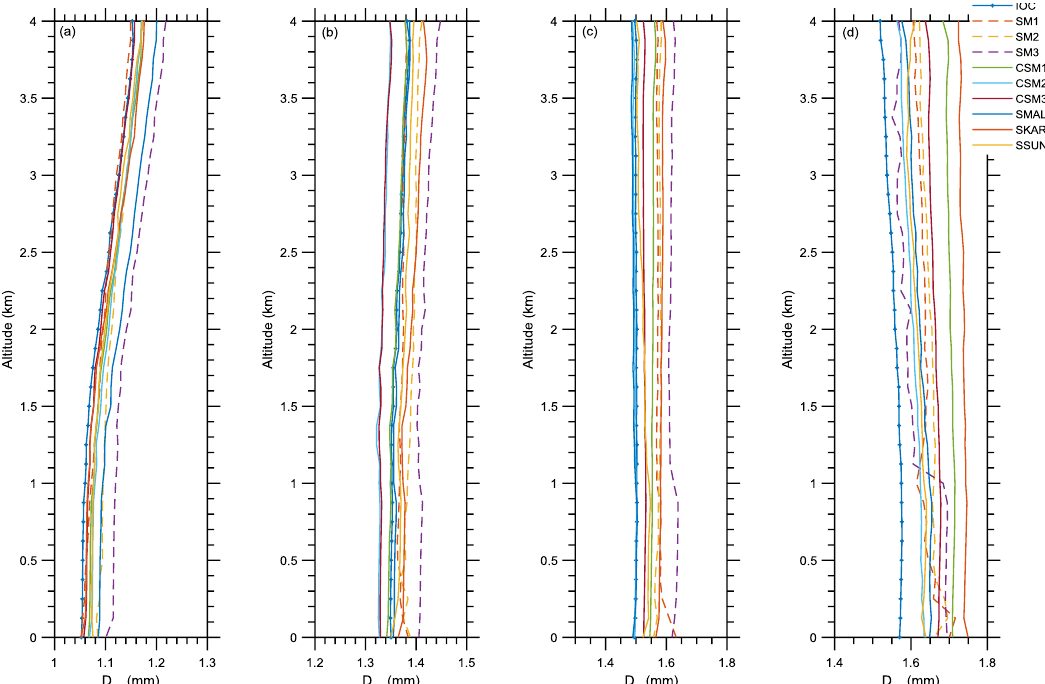
Figure 5. Vertical profile of mass-weight mean diameter ( D m ) for ten selected locations of stratiform rain for a) very light rain, b) light rain, c) moderate rain, and d) heavy rain. The BB strength (Δ Z ) for each location is slightly different. The values of Δ Z (in dBZ) for very light rain are IOC (4.28), SM1 (4.50), SM2 (4.48), SM3 (4.15), CSM1 (4.04), CSM2 (4.27), CSM3 (4.14), SMAL (4.21), SKAR (4.09), and SSUN (4.12). Furthermore, Δ Z for heavy rain are IOC (2.62), SM1 (2.79), SM2 (2.89), SM3 (2.24), CSM1 (3.24), CSM2 (2.80), CSM3 (2.95), SMAL (3.06), SKAR (2.63), SSUN (2.41). Thus, very light rain has a larger ∆Z than